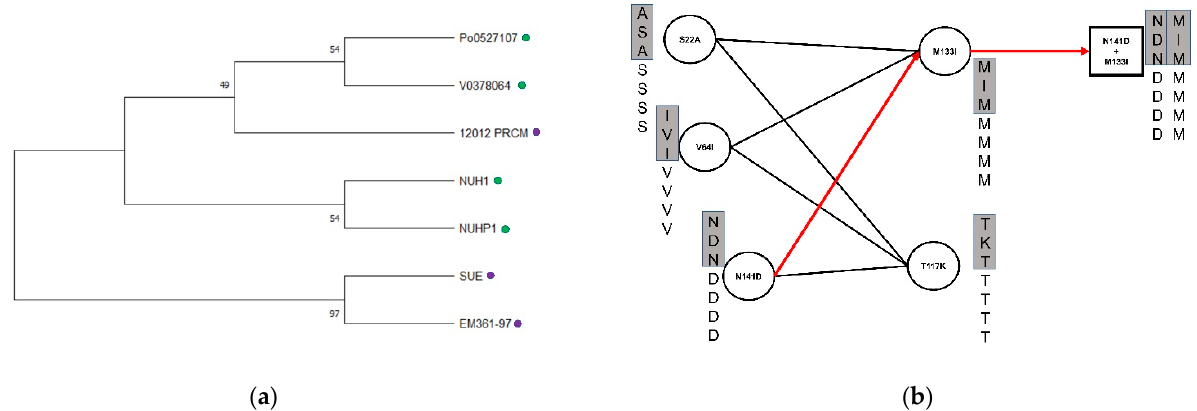
Figure 2. ( a ) Phylogeny of folp (DHPS) of seven E. anopheles strains. Green and purple circles indicate sensitive and resistance strains, respectively; ( b ) Identification of epi-static mutation via combinatorial enumeration. Each circle indicates a mutation point of seven E. anopheles , including three of them boxed in a gray bar, which were resistant to TMP/SMX. A line drawn between two circles represents a feasible mutation combination. An example of a combination (D141N+M133I) is shown on the right.